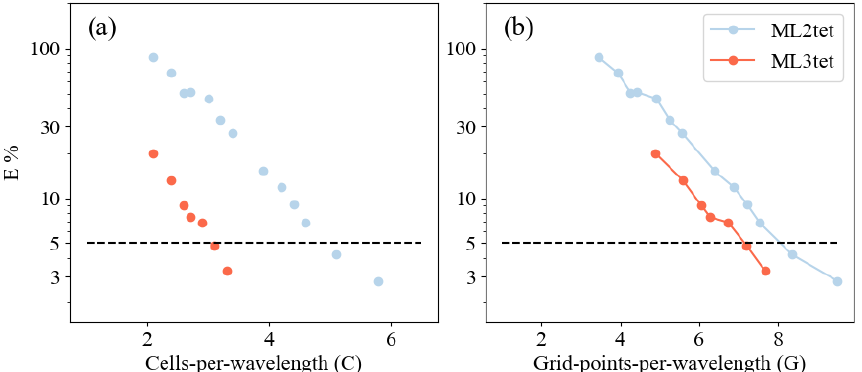
Figure 13. The 3D grid sweep, similar to Fig. 8 but for 3D elements. The E = 5% threshold is drawn as a horizontal dashed black line on all